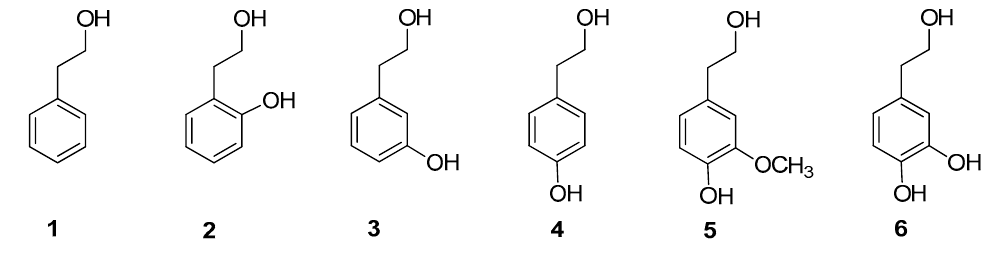
Figure 1. Phenethyl alcohols 1 – 6 .